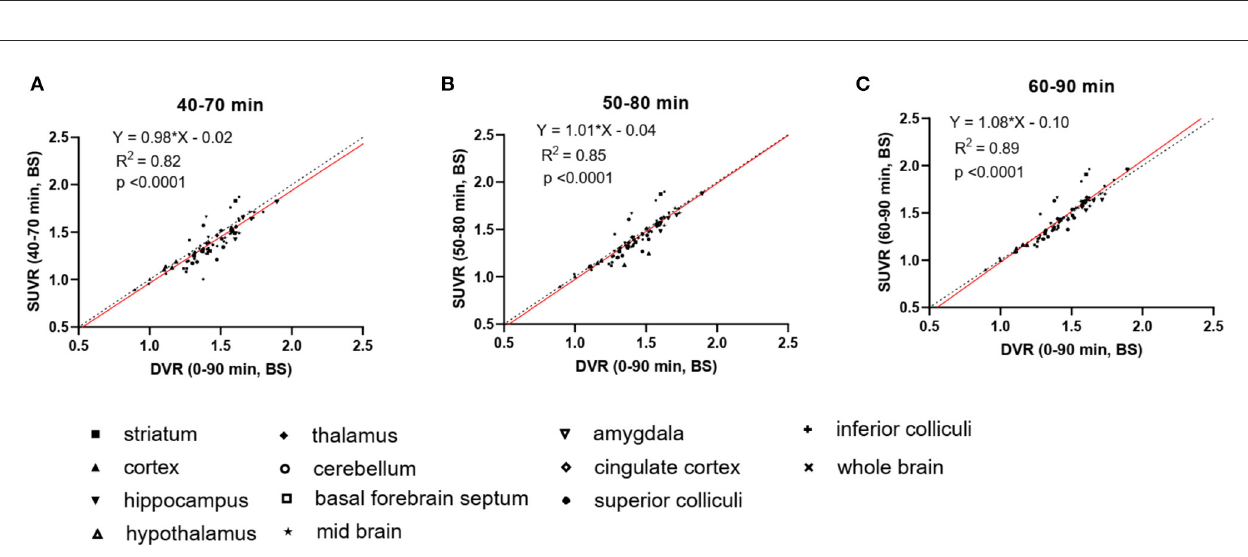
FIGURE2 Linear regression analysis of DVR and SUVR using averaged SUVs from three different imaging windows, i.e., (A) 40–70min p.i., (B) 50–80min p.i., and (C) 60–90min p.i. DVRs are calculated through SRTM using 90-min dynamic scan data and brain stem as reference region, N = 3 for each genotype. Dashed lines are lines of